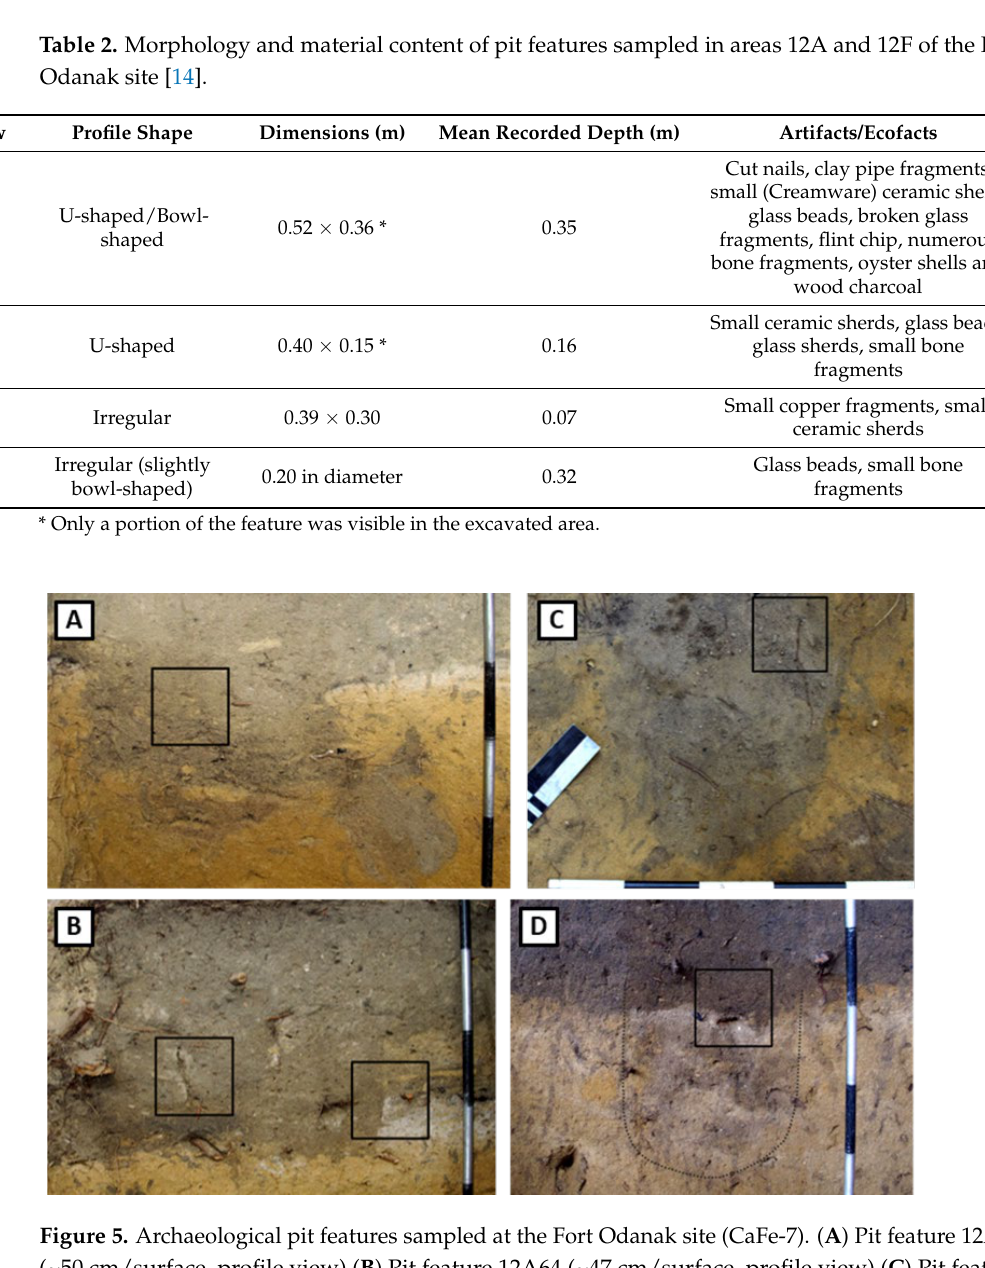
Figure 6. Stratigraphic representation of pit features sampled at the Fort Odanak site (CaFe-7). ( A ) Profile of pit feature 12A57 ( ⁓ 50 cm/surface) ( B ) Profile of pit feature 12A64 ( ⁓ 47 cm/surface) ( C ) Plan view of pit feature 12A72 ( ⁓ 55 cm/surface). ( D ) Profile of pit feature 12F50C ( ⁓ 35 cm/surface).